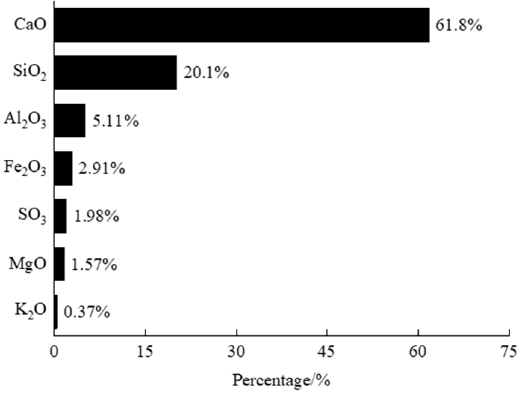
Figure 3. Chemical composition of 42.5R cement.